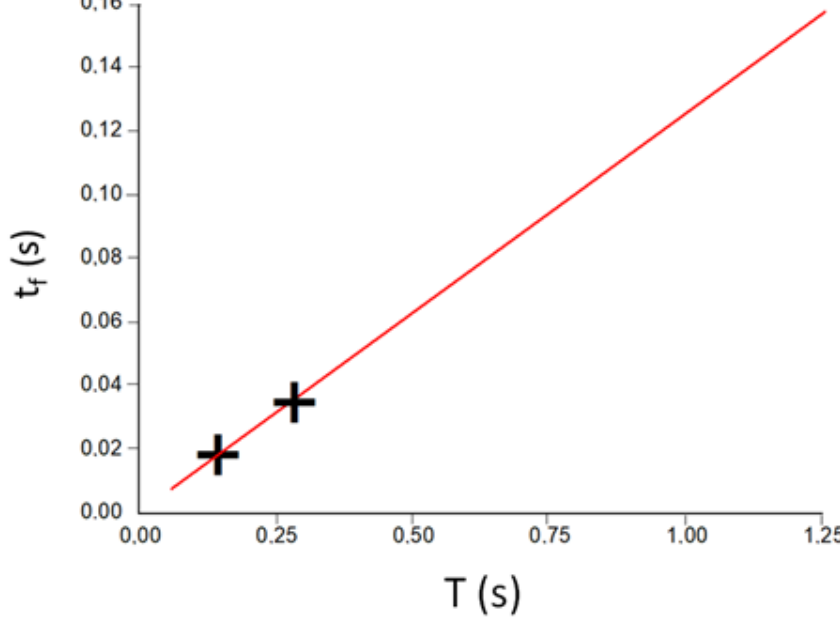
Figure 8. Flight time, t f , as a function of the period T, (+, this work; red line, [19]). Consequently, the total time [19], its sum, is t t + t f (P7) = 0.089 s. In the SPEX device, the bibliography data were used: t t = 0.0073 s and t f = 0.0269 s that drive to t t + t f (SPEX) = 0.0342